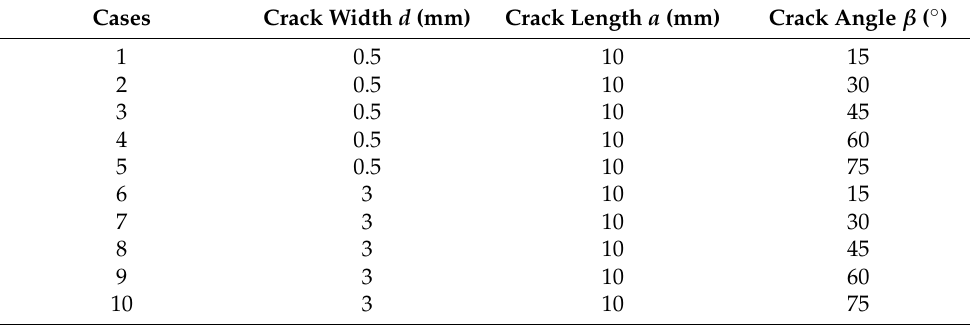
Figure 2. ( a ) Test machine; ( b ) Diagram of the loading of the concrete specimen with a single fracture. The applied compressive stress is represented by σ y ; β is the angle between the crack axis and the direction of loading; 2 a is the crack length; L is the specimen width, and H is the specimen height. Table 2. Crack parameters for specimens in uniaxial compression tests.